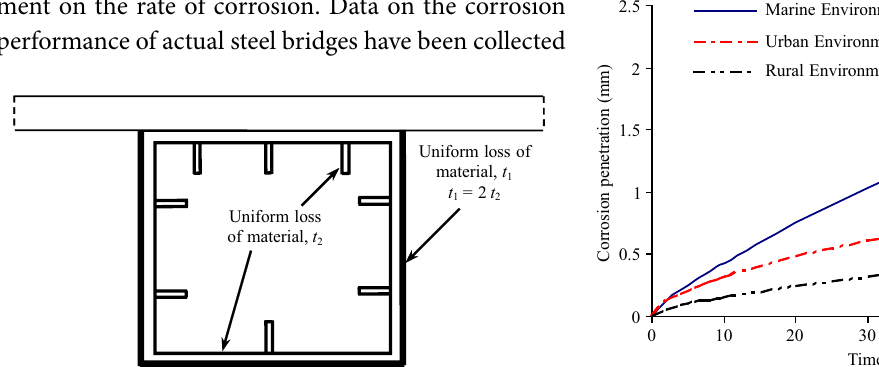
Fig. 1. Proposed model of corroded stiffened steel box girder (cross-section)